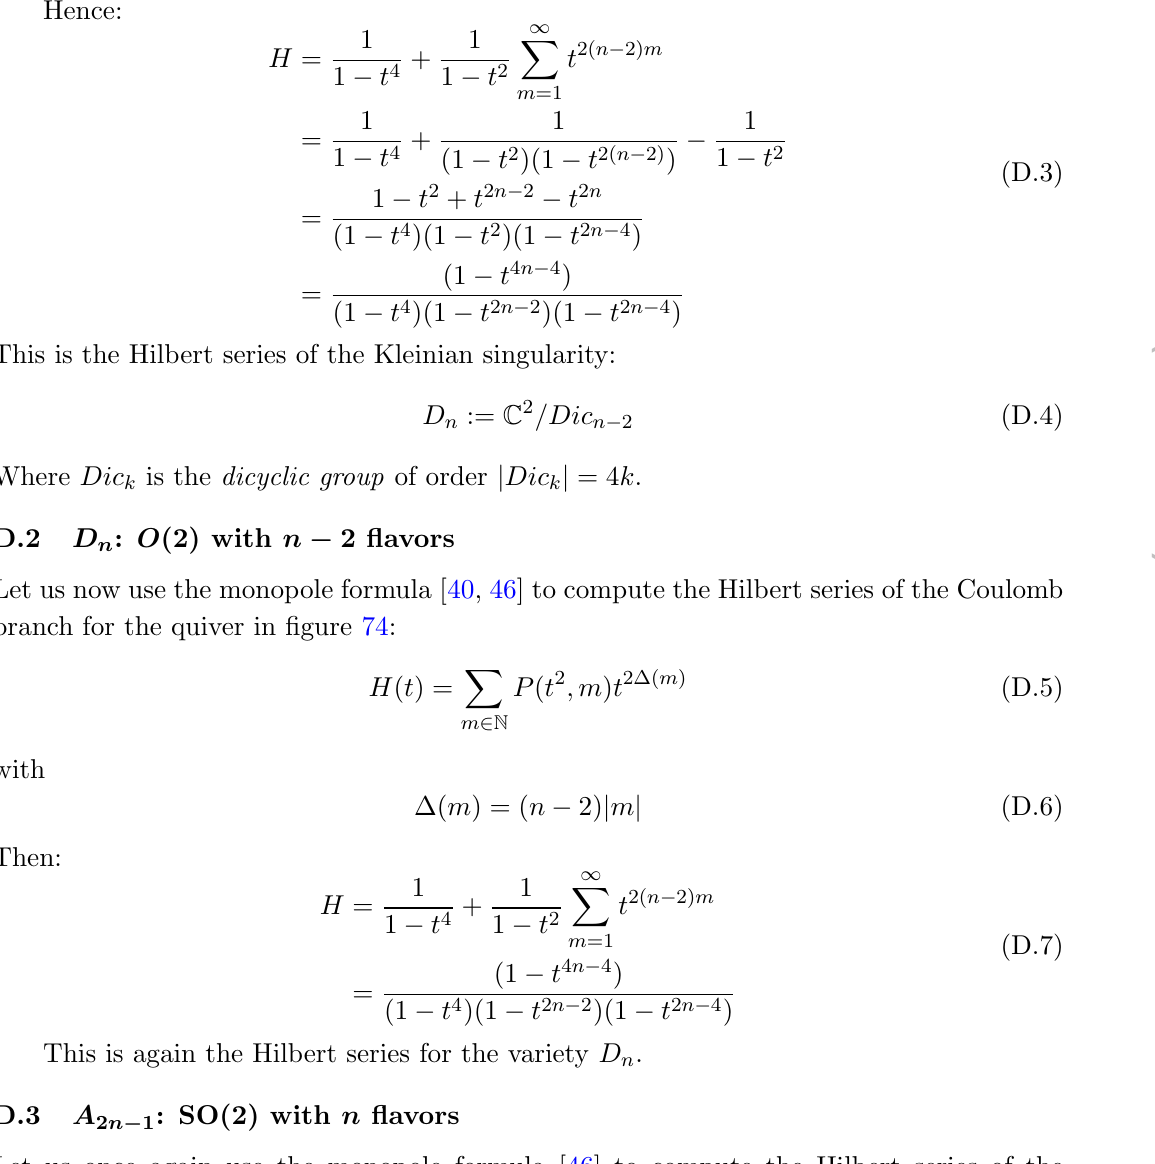
Figure 74. Quiver whose Coulomb branch is a D n subregular